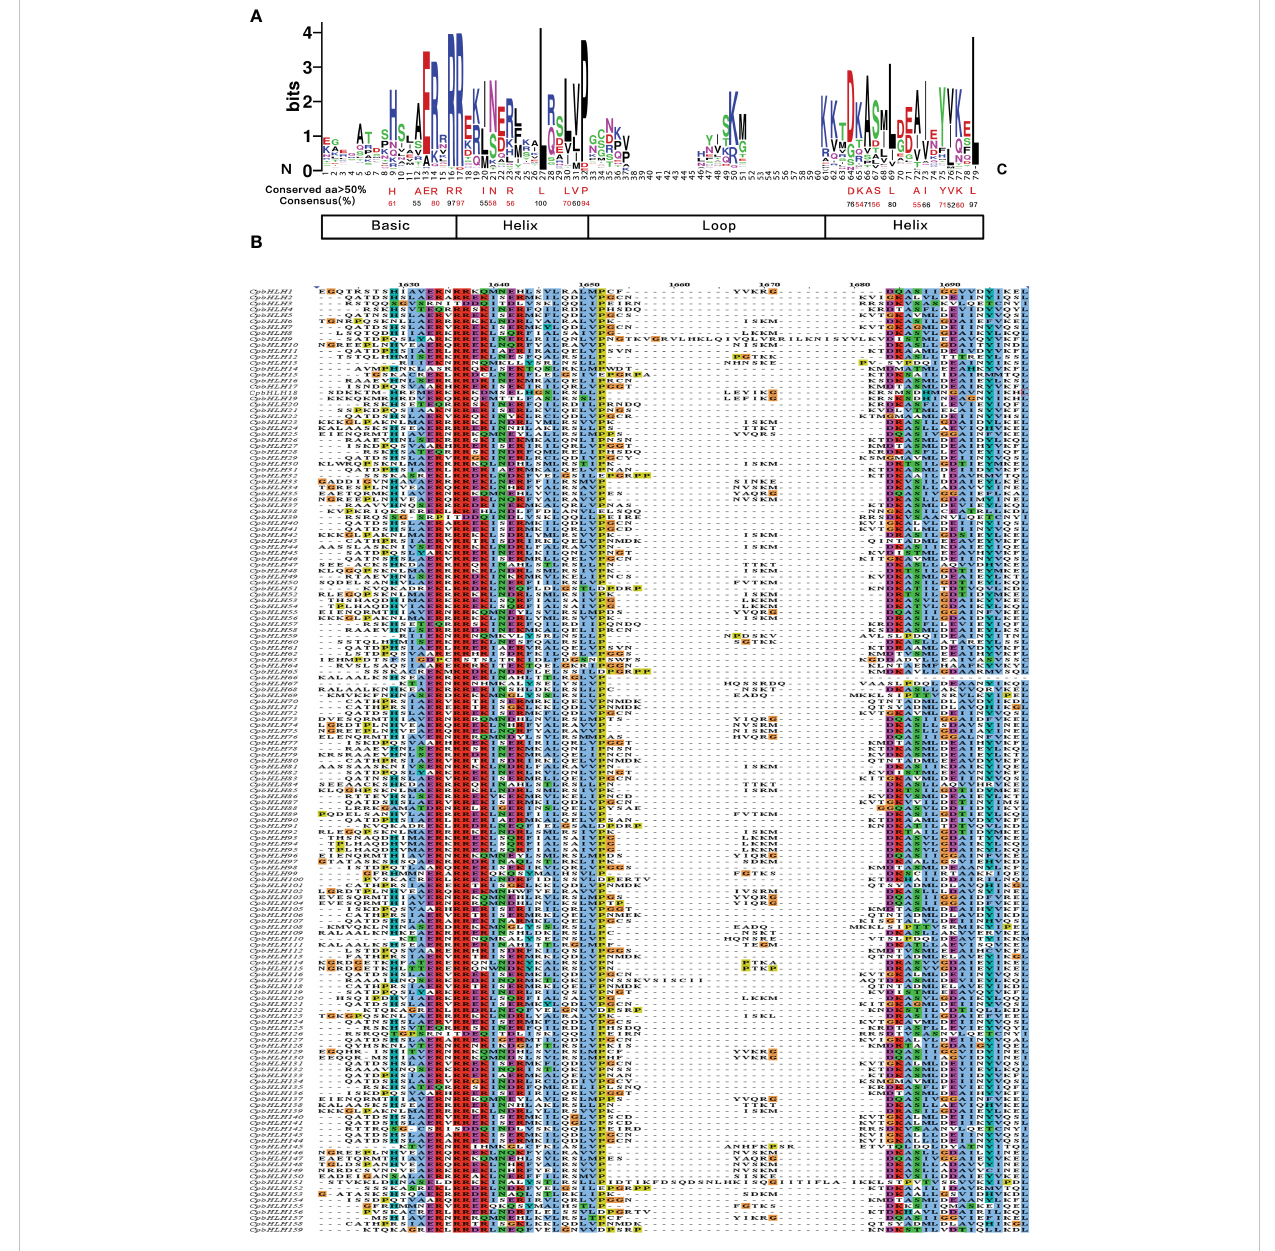
FIGURE 3 Multiple sequence alignments of the bHLH domains in CpbHLH proteins. (A) Visualization of conserved amino acids of bHLH domains of CpbHLH proteins. Amino acids with a conserved degree of more than 50 and their conserved degree were labeled using red and black colors for easy recognition which had no special meaning. (B) Multiple sequence alignments of the bHLH domains of 159 CpbHLH proteins, using the Clustal color